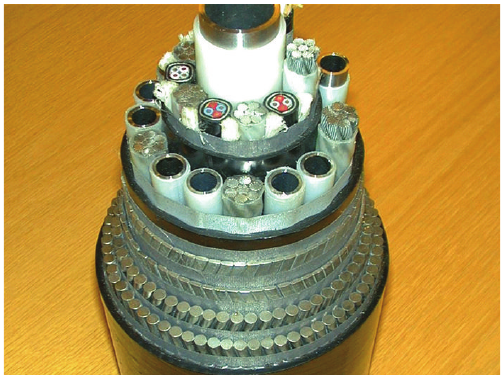
Figure 1: Umbilical